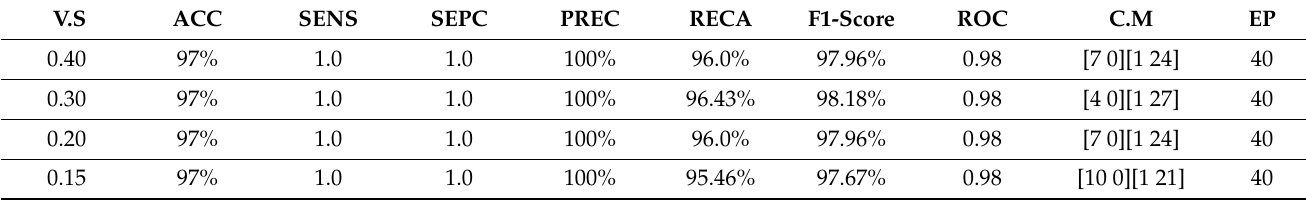
Table 3. SGD (rate of learning 0.001; momentum = 0.9). The loss function is binary cross en- tropy (BCE).